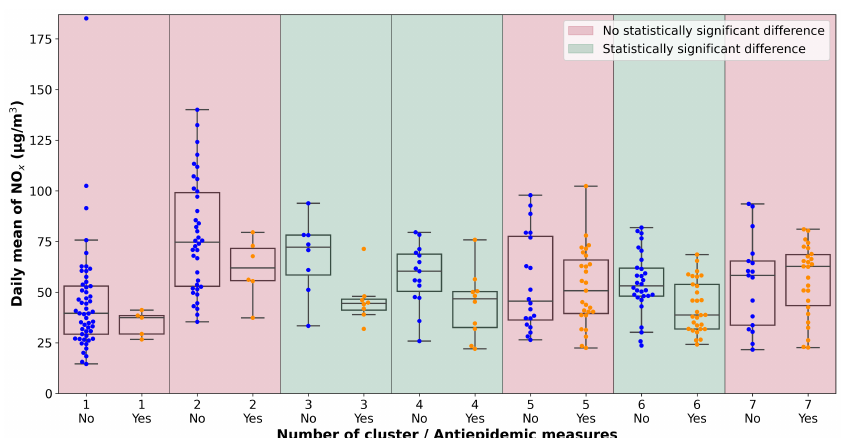
Figure 7. Results of the ANOVA test, Ostrava- ˇCeskobratrská, NO x